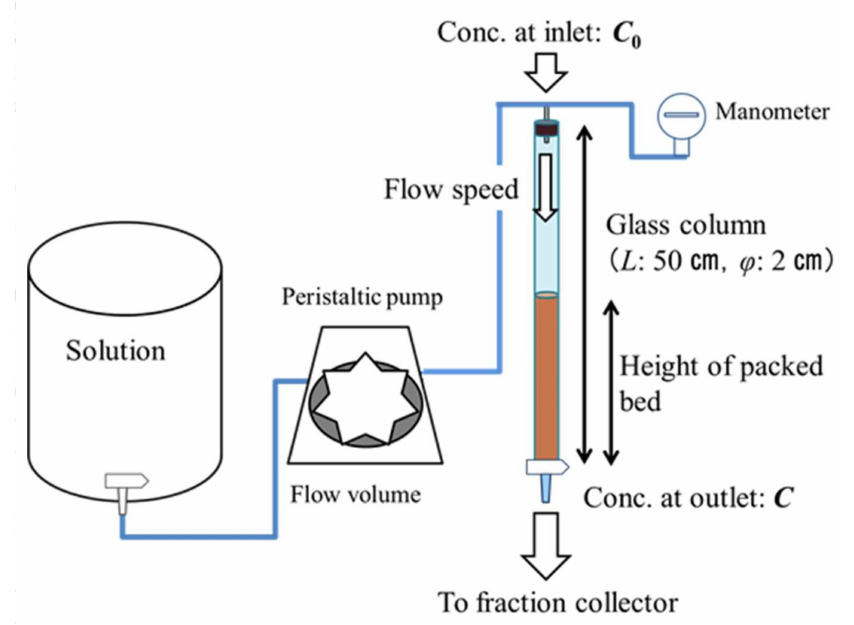
Figure 3. Schematic of the apparatus used in the fixed-bed adsorption